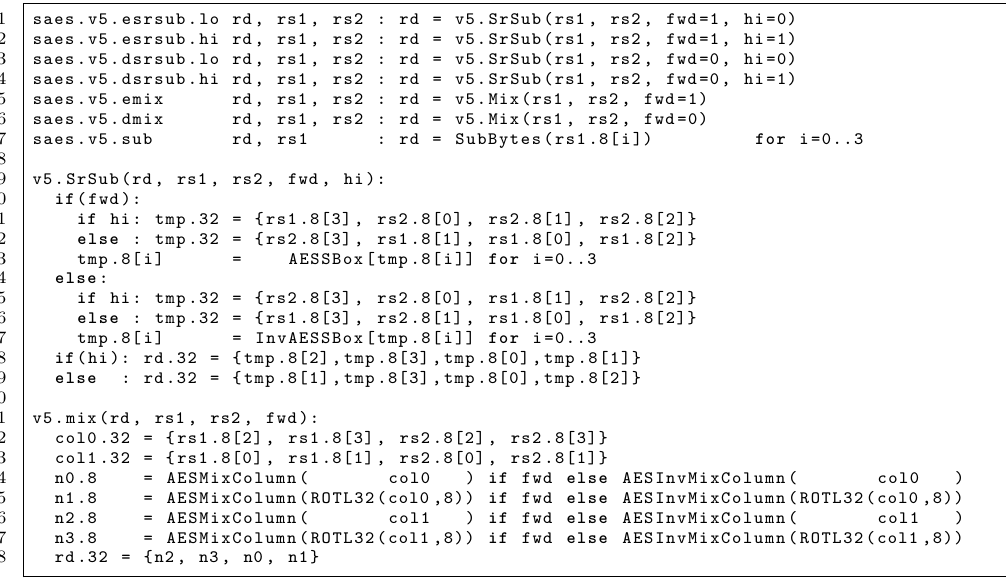
Figure 6: Instruction mnemonics, and their mapping onto pseudo-code functions, for V 5